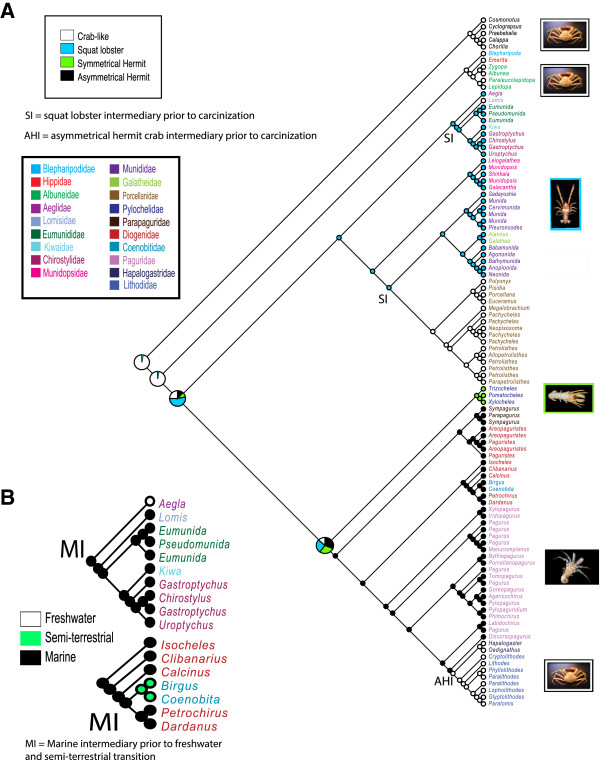
Ancestral state reconstruction analysis using maximum likelihood methods for body shape and habitat transition within Anomura. Colored taxa correspond to anomuran families as noted in legend. Pie charts represent the likelihood of the ancestral state. (A) Character states for body shape were defined as crab-like white, squat lobster blue, symmetrical hermit green and asymmetrical hermit black. (B) Character states for habitat were defined as freshwater white, semi-terrestrial green, and marine black. Subtrees are shown for the transition into freshwater (Aeglidae) and semi-terrestrial habitats (Coenobitidae).